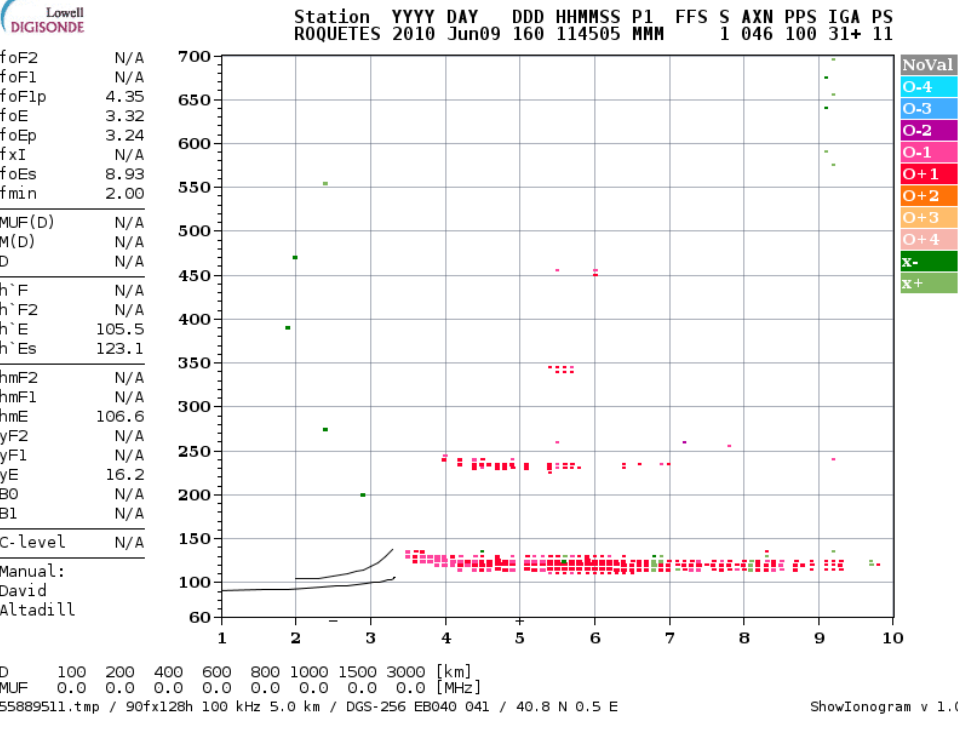
Figure 1. A particularly strong blanketing sporadic-E layer over Roquetes, Spain. In this scenario, the foF2 cannot be determined because fbEs > foF2.